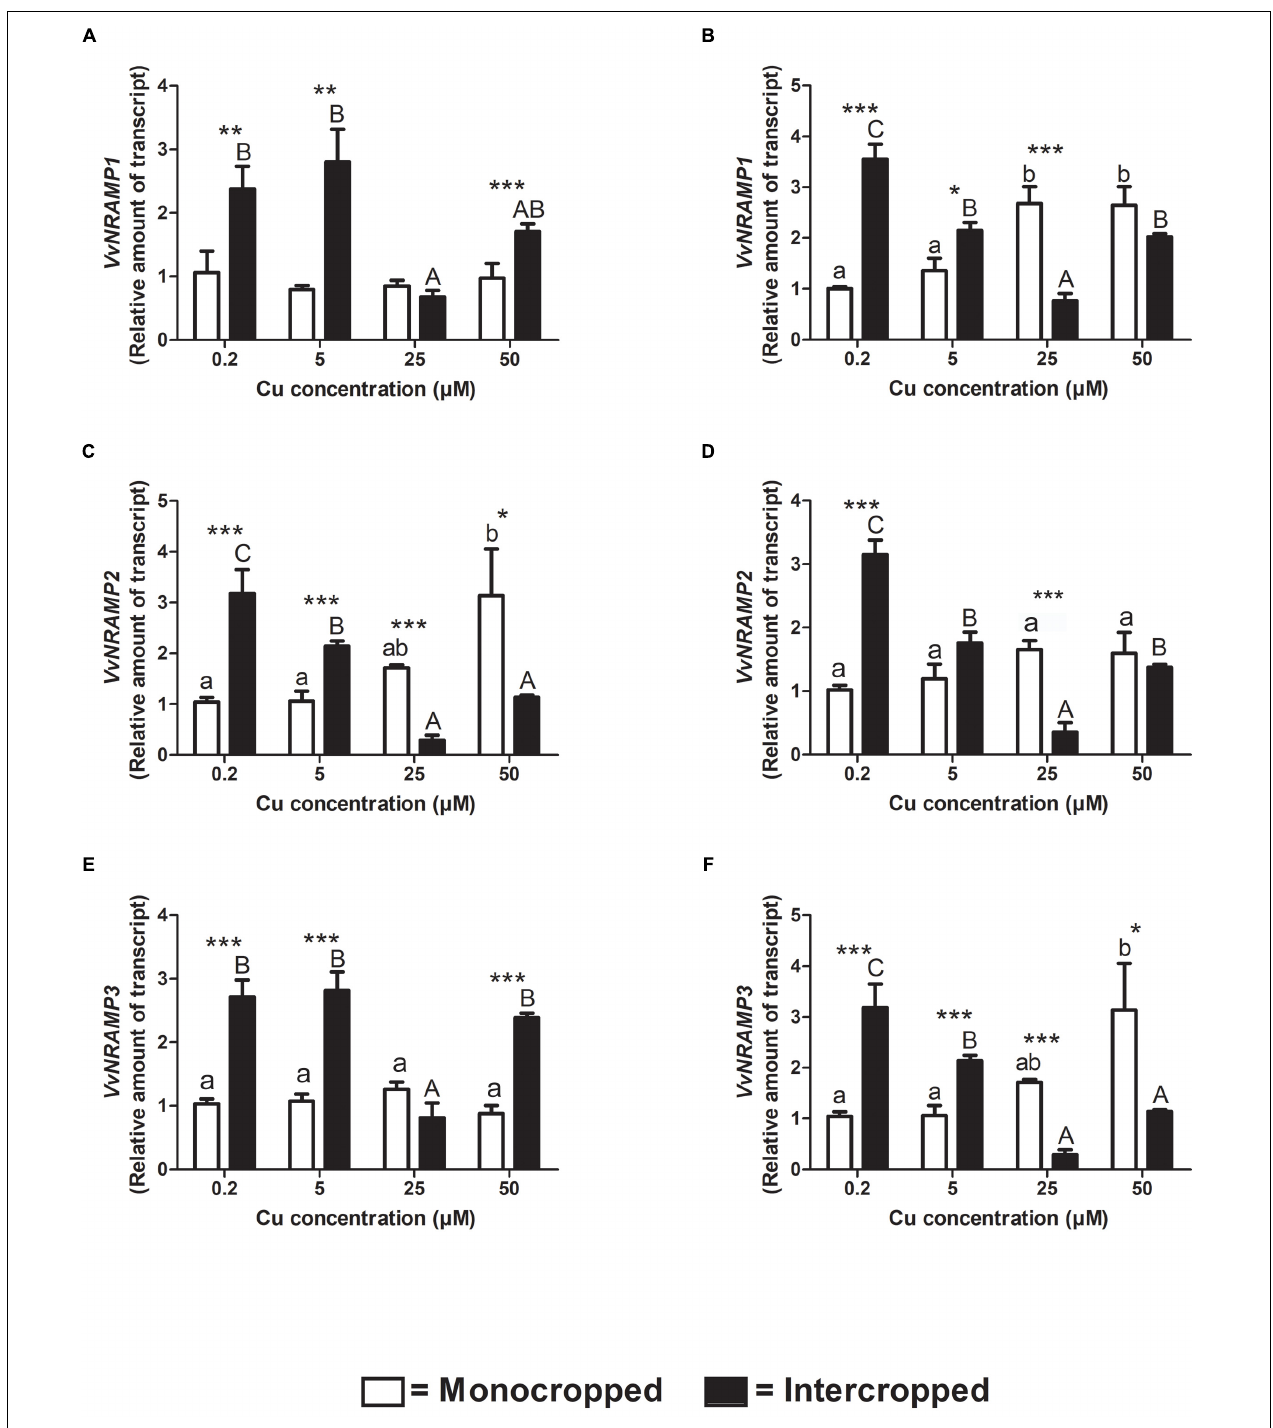
FIGURE 8 | Quantitative real time RT-PCR analyses of VvNRAMP genes in rootstock plants. Root apex genes expression of VvNRAMP1 , VvNRMP2 , and VvNRMP3 determined in mono- and intercropped Fercal (A,C,E) and 196.17 (B,D,F) rootstocks. Transcripts levels are reported as relative amount of transcripts referred to the gene expression of monocropped rootstock grown at 0.2 µ M Cu. The data are reported as means ± SE of three biological replicates. Different letters indicate significantly different values as determined using one-way ANOVA with Tukey post hoc tests ( p < 0.05). Lower case letters indicate the statistical significance for monocropped plants in the different Cu concentrations, whilst upper case letters indicate the statistical significance for intercropped plants grown in the different Cu concentrations. Stars indicate the significance (Student’s t -test) between the gene expression of mono- and intercropped rootstocks ( ∗ p < 0.05; ∗∗ p < 0.01; ∗∗∗ p <